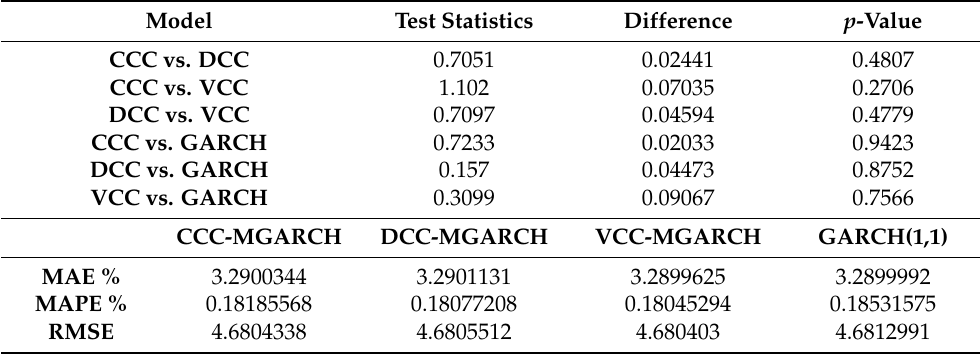
Table 5. Diebold–Mariano